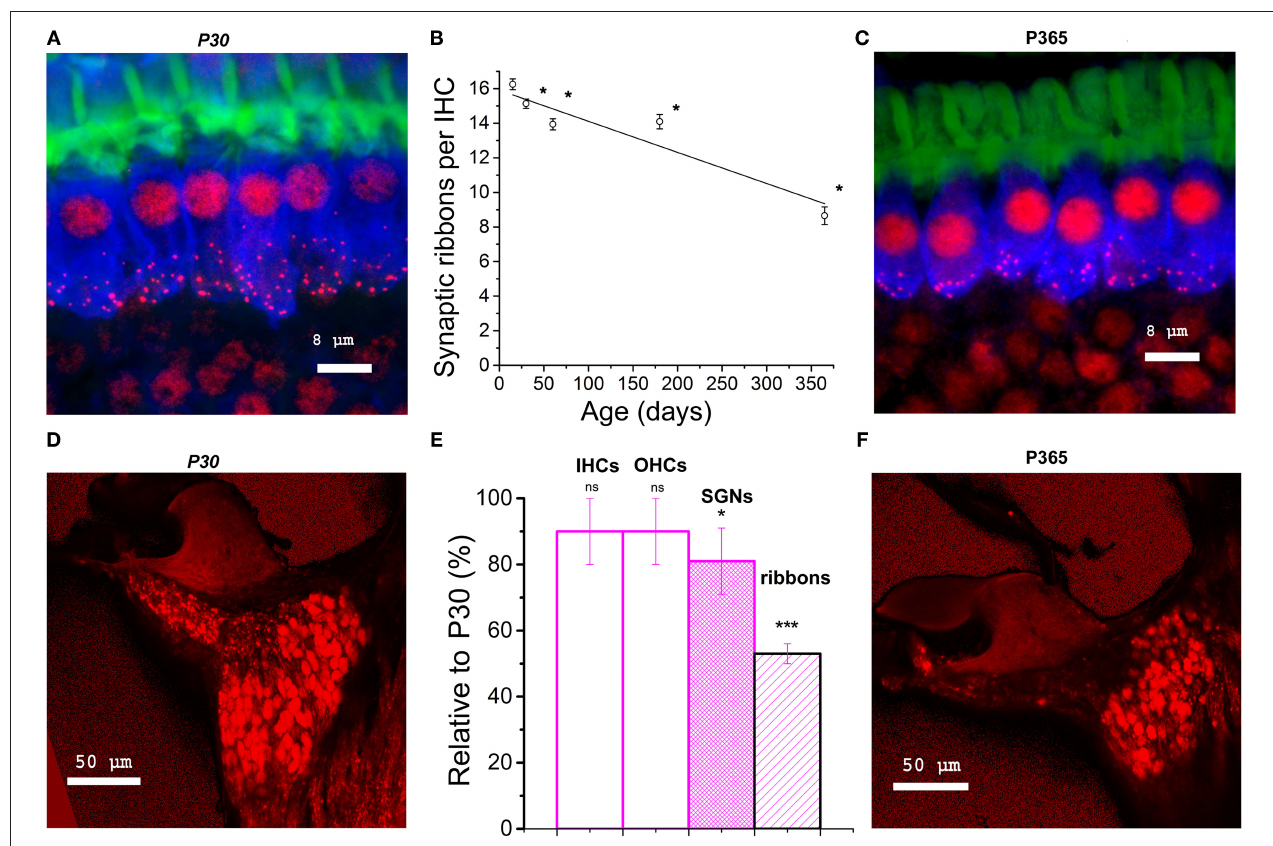
FIGURE 2 | Synaptic ribbon loss in aging IHCs and comparative density of spiral ganglion neurons. (A–C) Confocal immunofluorescence imaging of IHCs from P30 and P360 C57BL/6J mice. Image resulted from stack reconstructions of 22 slices of 0.3 µ m thickness, showing F-actin (green, labeling the hair bundles), otoferlin (blue; a synaptic Ca 2 + sensor labeling the entire IHC body) and synaptic ribbons (Ribeye/CtBP2, red dots). The white bars indicated 8 µ m. (B) Plot of synaptic ribbon counts per IHC as a function of age in C57BL/6J mice (black) in the mid-frequency cochlear region (8–16kHz). Asterisks indicate significant difference with p < 0.05 (comparison with P15 C57BL/6J mice, one-way ANOVA post-hoc Tukey test). 203, 306, 306, 306, and 295 ribbons were, respectively, analyzed at P15, P30, P60, P180, and P365 in 3–5 mice at each age. (D–F) Confocal immunofluorescence imaging of cochlear transversal sections from P30 and P360 mice (8–16kHz area) where neurons and their afferent dendrites are labeled with dextran amines 3,000. (E) Analyzed in the mid-cochlea (8–16kHz), comparative histogram of hair cells counts, SGNs and synaptic ribbons (three mice at each age relative to young mature P30 C57BL/6J mice). The asterisks indicated statistical difference with p < 0.05 (from left to right p = 0.37, 0.14, and 0.020 for SGNs and p = 1.01E − 14 for ribbons, using unpaired t -test). Note the reduction in SGNs and the drastic decrease of the fluorescent labeling of the afferent nerve fibers projecting to the organ of